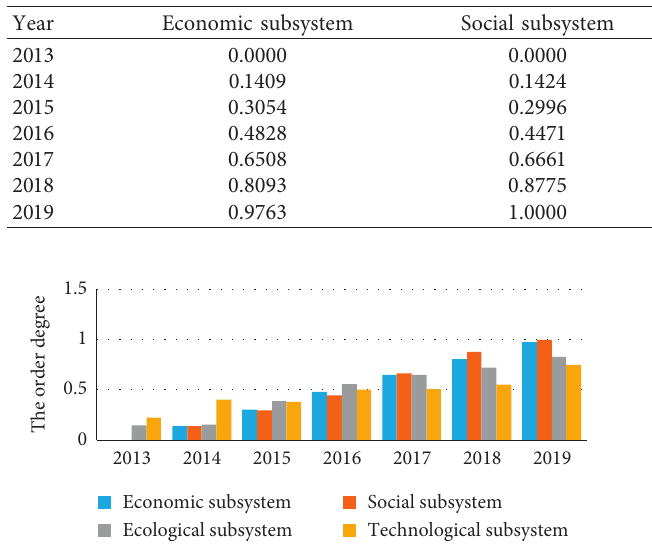
Figure 2: The order degree of four subsystems.